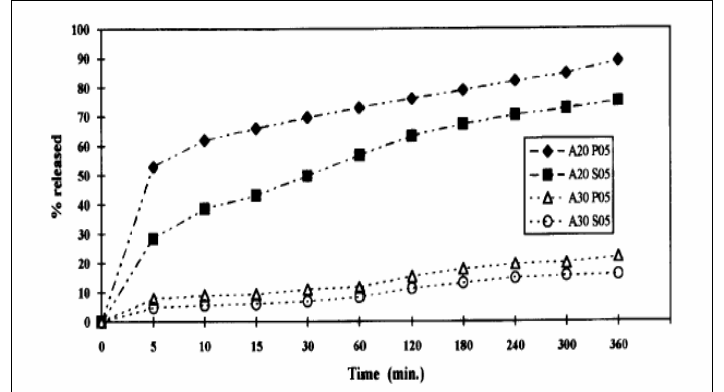
Figure 3. TPH release from tablets containing 20% and 30% of Sclg with 0.5%